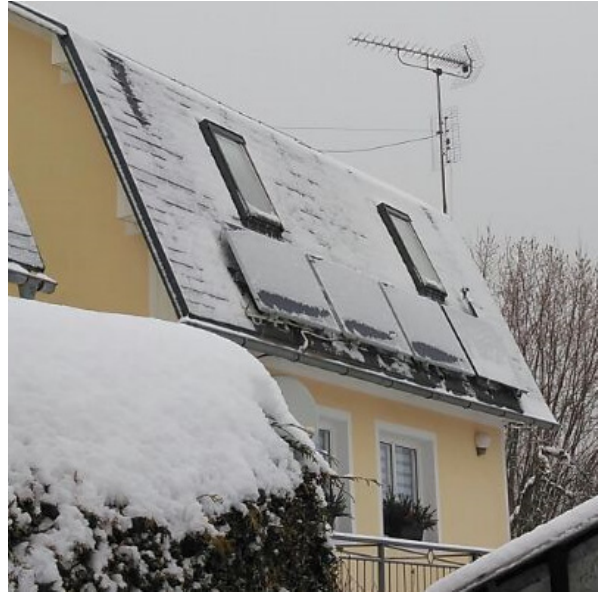
Figure 9. Main system electric power and TES state of charge profiles for the 10 December. In this case, the system-level KPIs are lower but still relevant RES (61.9%), mainly driven by HP contribution. The SSR is reaching just 9.4%. On the other side, the low PV production and high HP consumption artificially enhance the SCR up to 98%. The SF does not make sense, as the ambient air contribution is much greater than the solar gain. The previously presented day is the most common day type in the period and that is its underlying value. However, the low solar contribution may reduce the interest of its analysis, as it could be considered a simple air-water HP. Thus, an exceptional high irra- diance cold day is discussed below, the 14th January. The plane of array irradiation is 3.03 kWh/m 2 , − 2 °C mean ambient temperature and once again no wind at all (0.46 m/s). The day is a Sunday, and the family seems to be not at home, as there is no DHW consumption. Figure 10 shows the day operation with a repetitive accidental starting pattern. The sys- tem finally starts running at the 6th attempt around 9h30. The high irradiance morning drives the HP under the highest operation range till 12h40, even with an excess electricity grid injection. The morning period is only affected by a short 20 min cloud, but the great solar contribution suddenly disappears. The afternoon is characterized by almost null ir- radiation (5% of the day), but the system continues running at low-level extended booster till 16h50. The 7h day operation increases the TES temperature to 15 °C.